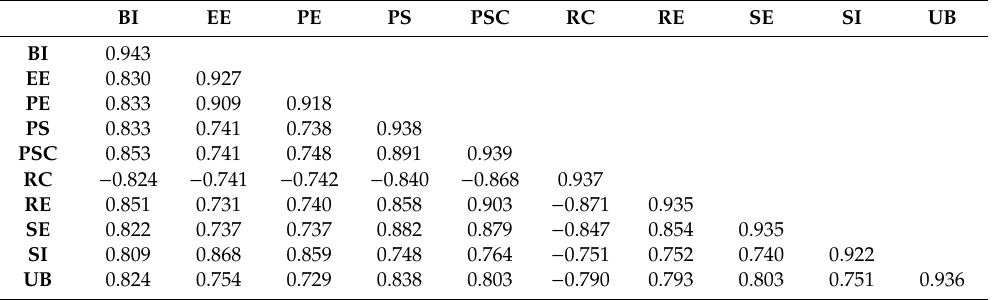
Table 4. Discriminant validity test: Fornell–Larcker criterion.